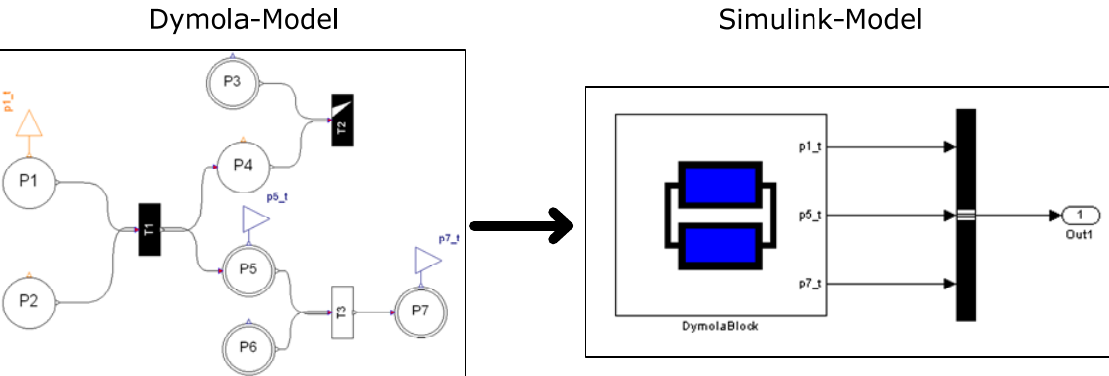
Figure 21: Connection Dymola and Matlab/Simulink by a Simulink Interface (DymolaBlock), left: Petri Net modeled by the Petri Net library in Dymola, right: Simulink interface of the Dymola-model in Matlab/Simulink.